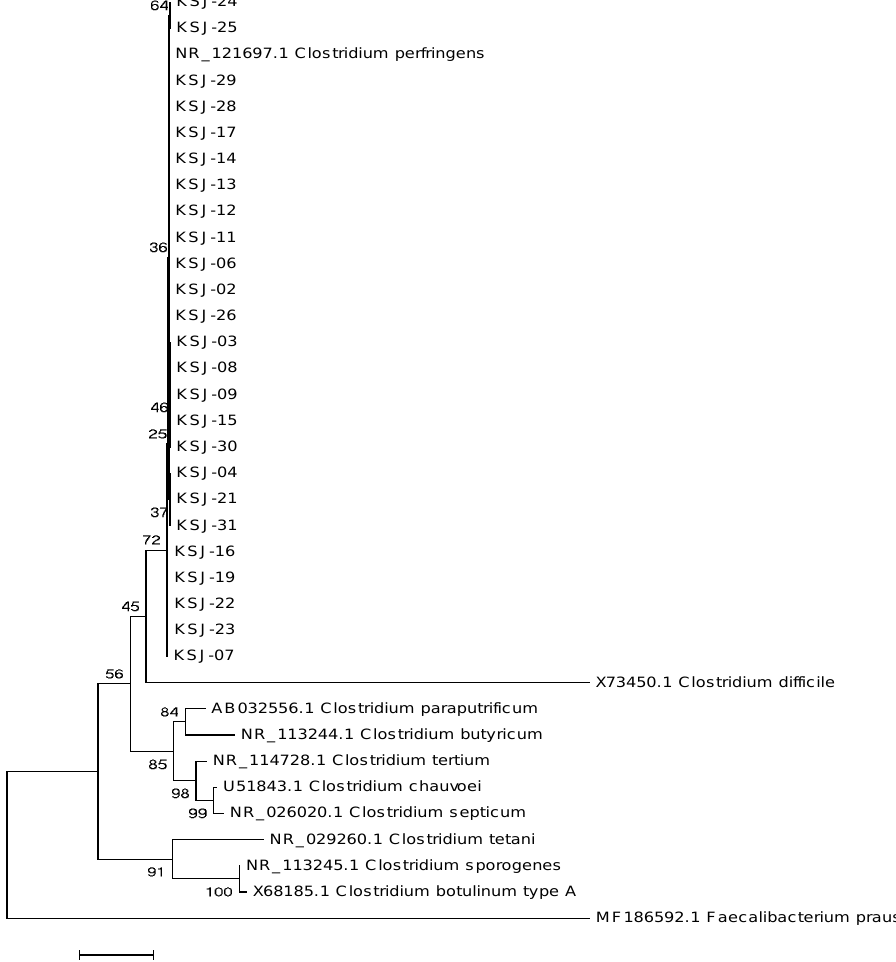
Figure 1. Phylogenetic tree of C. perfringens isolated from horse feces and contaminated soil. The nucleotide sequences of all 25 new strains (named KSJ strains) are identical to those of the NR_121697.1 C. perfringens (ATCC 13124 C. perfringens standard strain). This tree was constructed by the Neighbor-Joining method, MEGA 6.0 program.